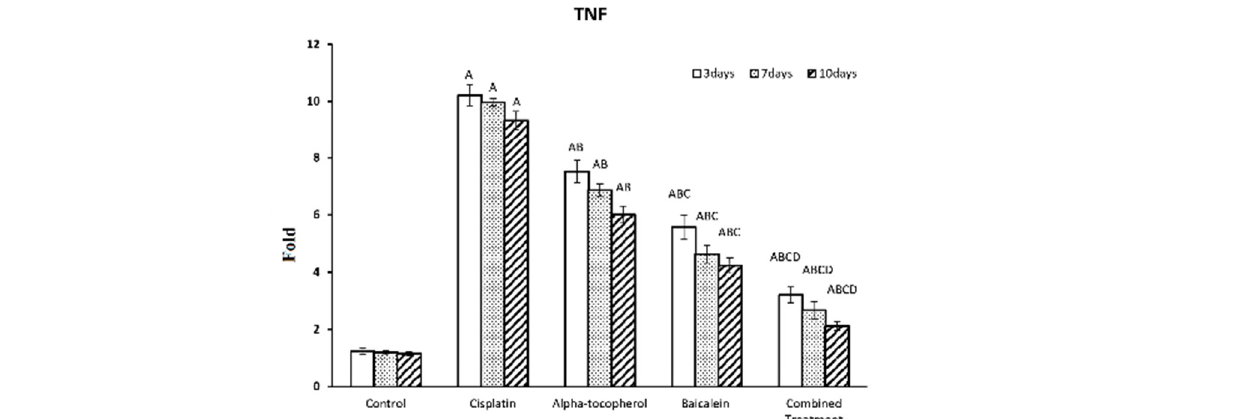
Figure 4. Effect of α -tocopherol and baicalein administration on NF- κ B, IL-6, and TNF in control and treated groups. All data are expressed as mean ± SEM. Significant vs. control group refers to A, while significant vs. (cisplatin, -tocopherol, and baicalein) treatment groups refers to (B, C, D), respectively.